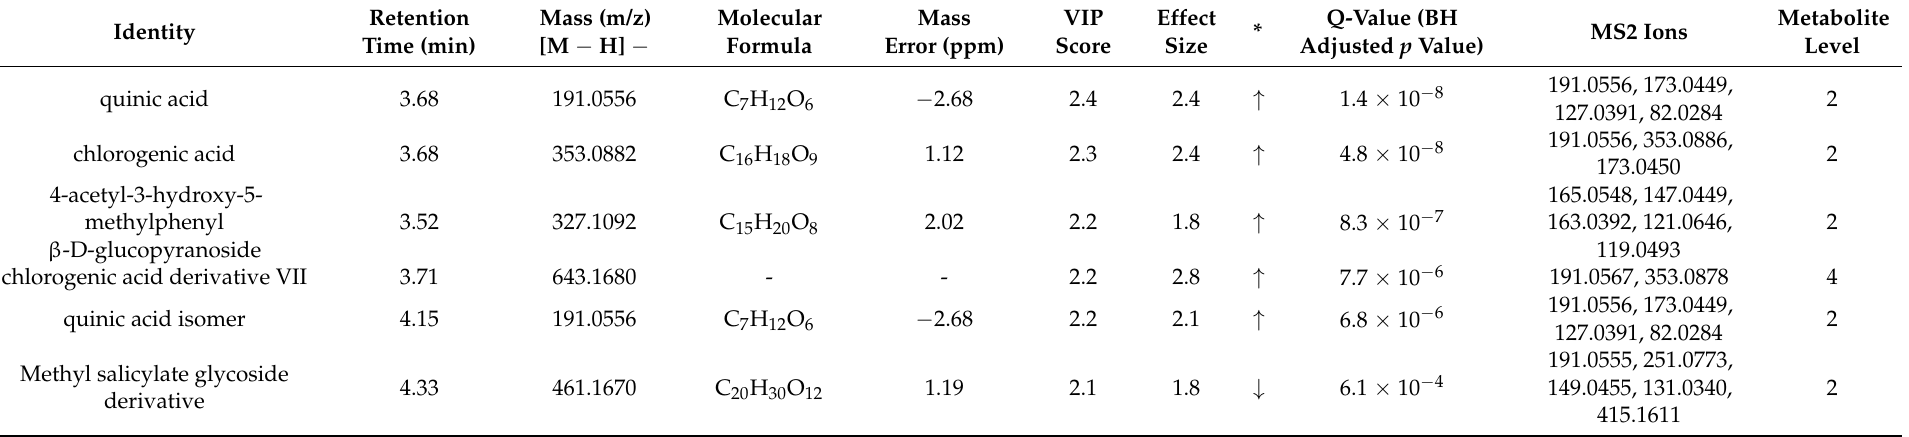
Table 2. Metabolites identified in UHPLC-HRMS ESI- data that were significant (VIP > 1.5) in the OPLSDA model between NV HIGH compared to NV LOW apple spur buds with associated effect size. Benjamini–Hochberg adjusted p values (Q-values) indicate those metabolites that are significant in the linear model with the (y ~ return bloom) for NV LOW , NV MID and NV HIGH